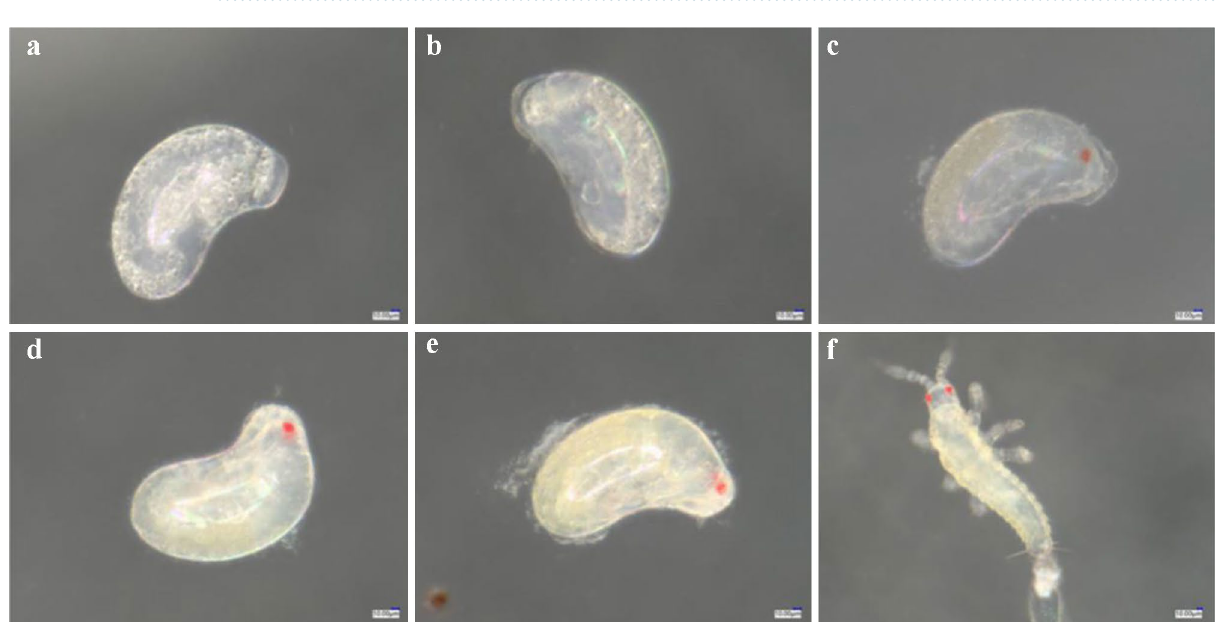
Figure 13. The effect of spirotetramat on embryonic development of F. occidentalis 24-h-old eggs. ( a ) Frankliniella occidentalis 24-h-old eggs; ( b ) eggs developing 12 h after spirotetramat treatment; ( c ) eggs developing 24 h after spirotetramat treatment; ( d ) eggs developing 36 h after spirotetramat treatment; ( e ) eggs developing 48 h after spirotetramat treatment; ( f ) eggs hatching as larvae after 60 h of